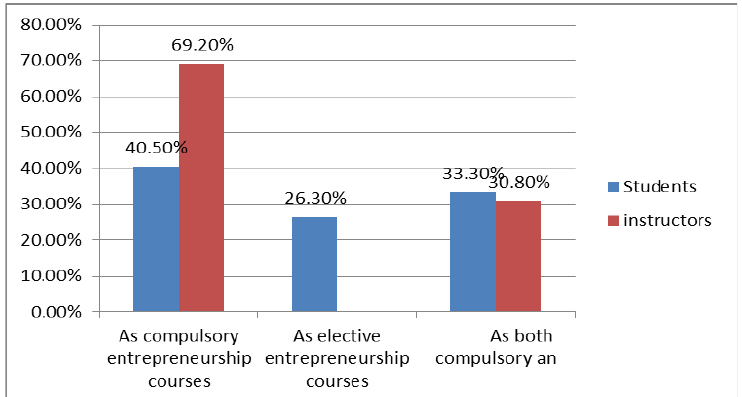
Figure 2: The way entrepreneurship courses are provided